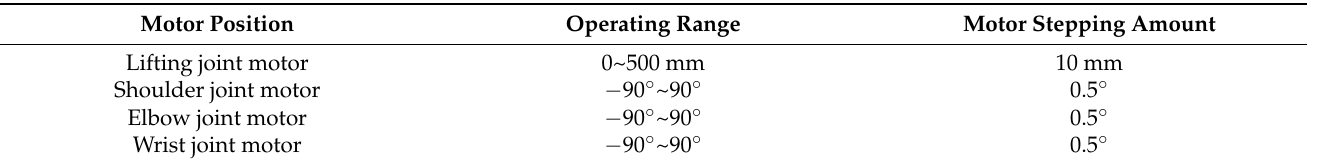
Figure 2. Single manipulator joint motor position. Table 1. Motor configuration of single manipulator.